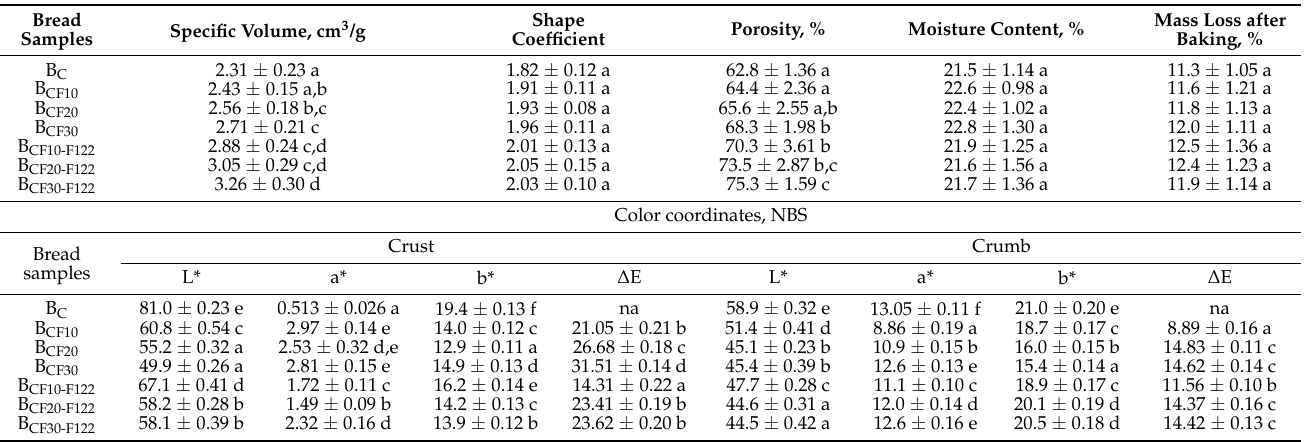
Table 6. Bread specific volume, porosity, shape coefficient, mass loss after baking, total color change ( ∆ E), and color characteristics of the bread crust and crumb.